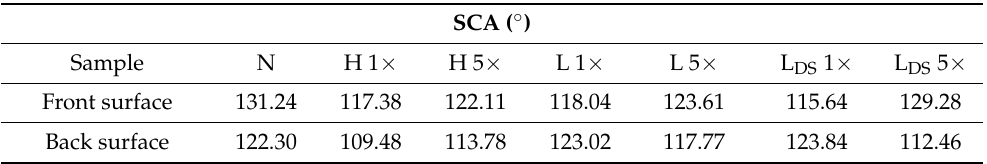
Table 4. The average SCA of the liquid droplet with the front and back surface of the medical mask before and after washing.